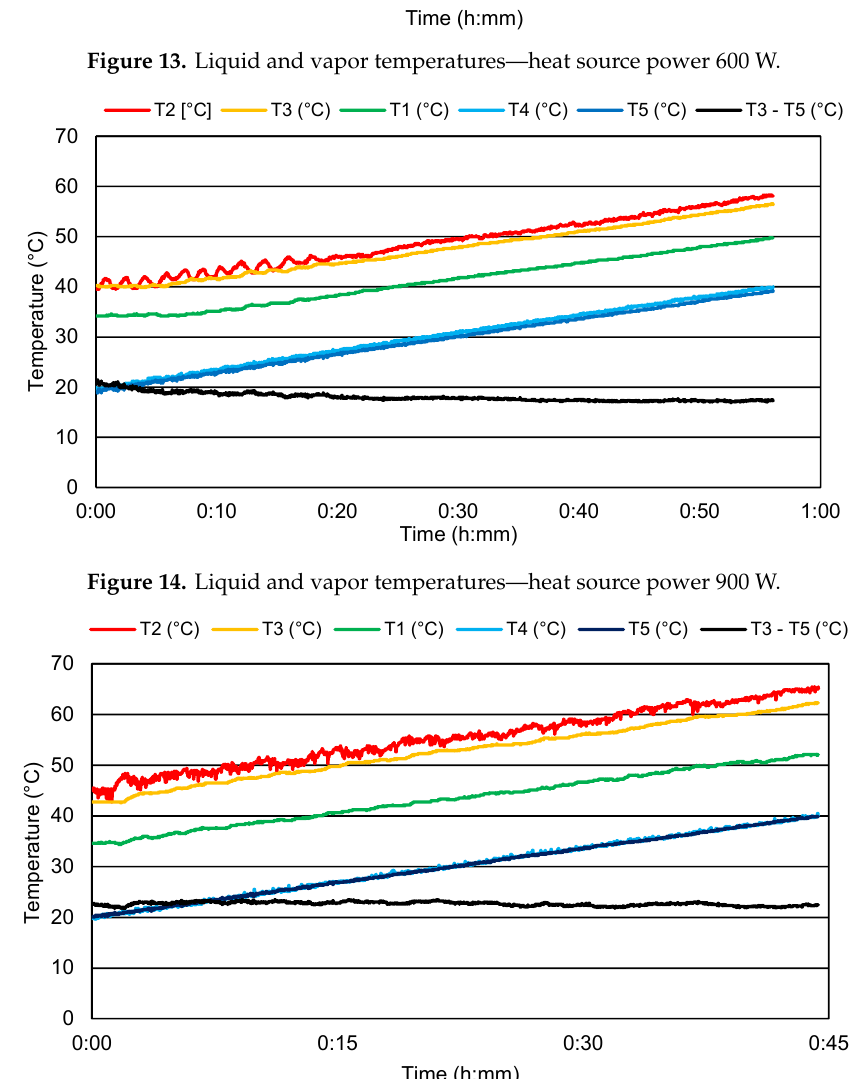
Figure 15. Liquid and vapor temperatures—heat source power 1200 W.